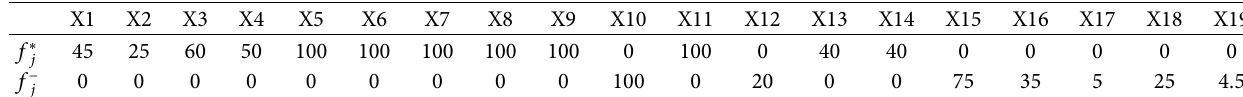
Table 14: Te best value and worst value for buildings.